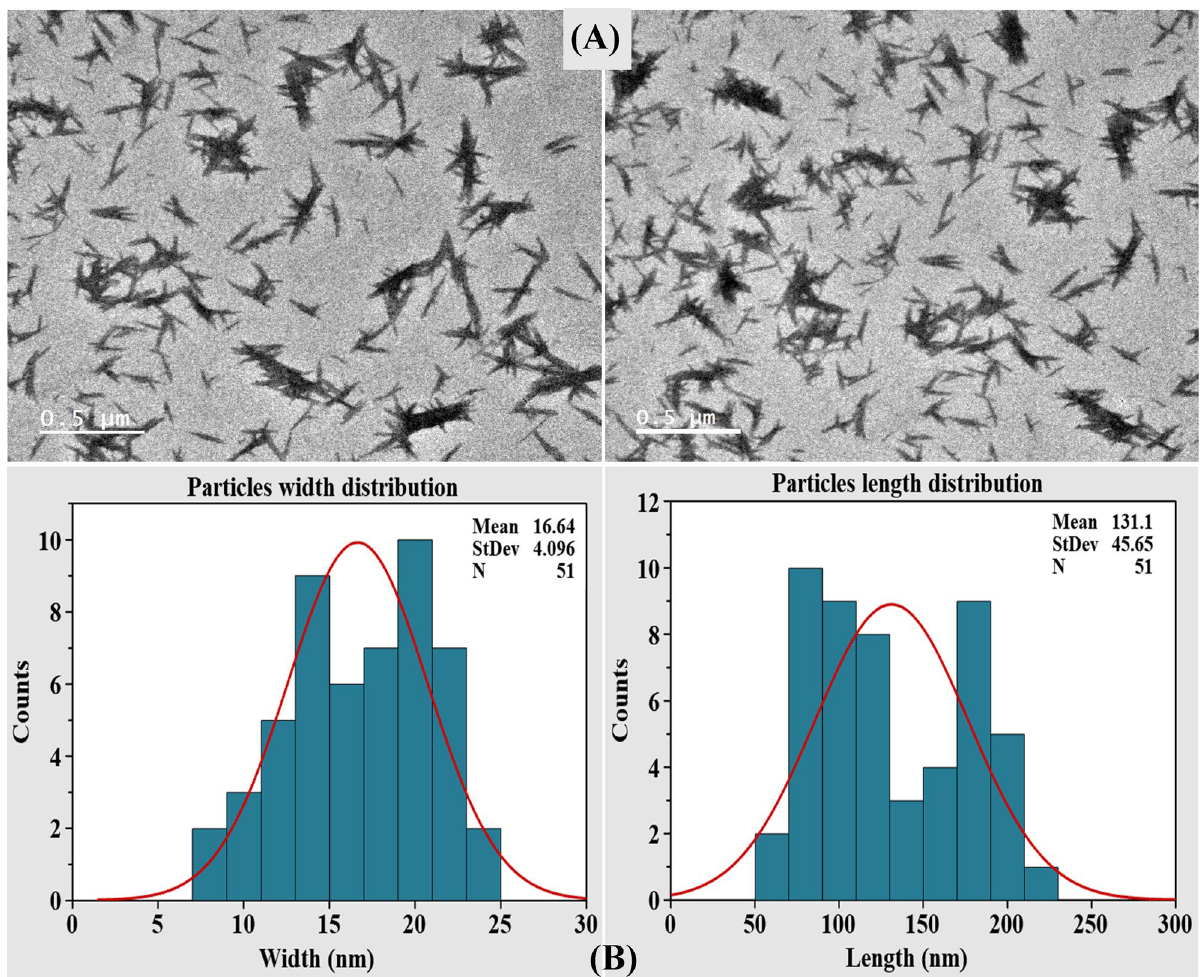
Figure 7. ( A ) Transmission electron microscopy morphology of BNC sample; ( B ) the histograms of length and width distributions for the produced